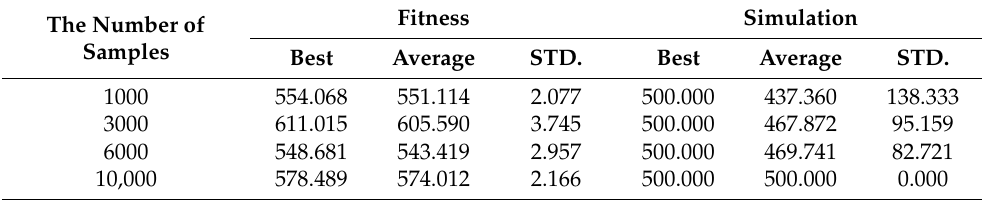
Table A1. Performance of SGAs based on the number of samples in the cart-pole balancing. The Number of